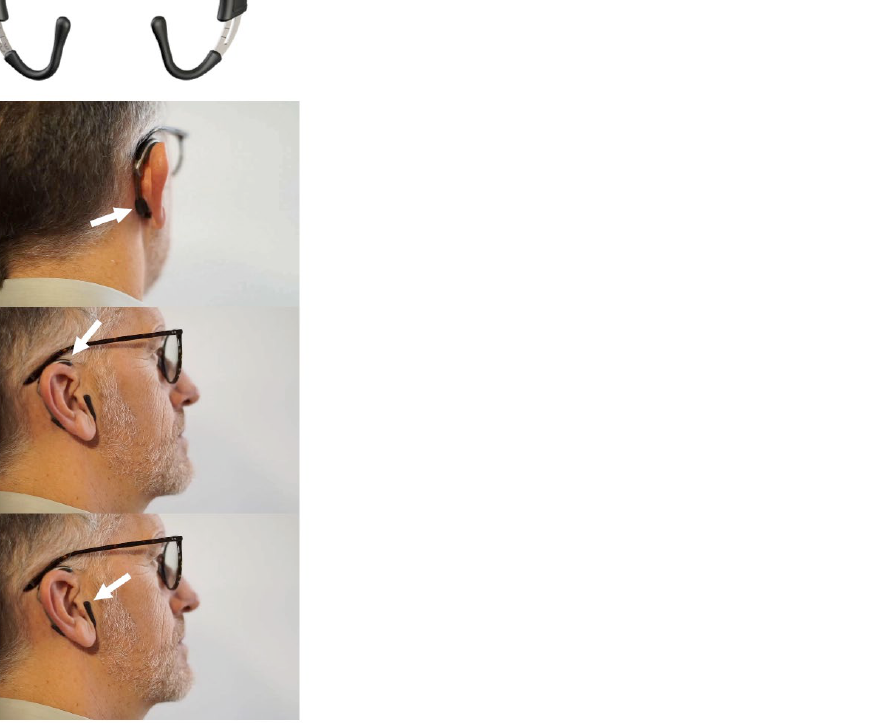
Figure 1. Acupressure device. Picture of the acupressure device (top) and how it should be mounted around the ear. The white arrows point to the parts of the device that can be adjusted to the individual ear.